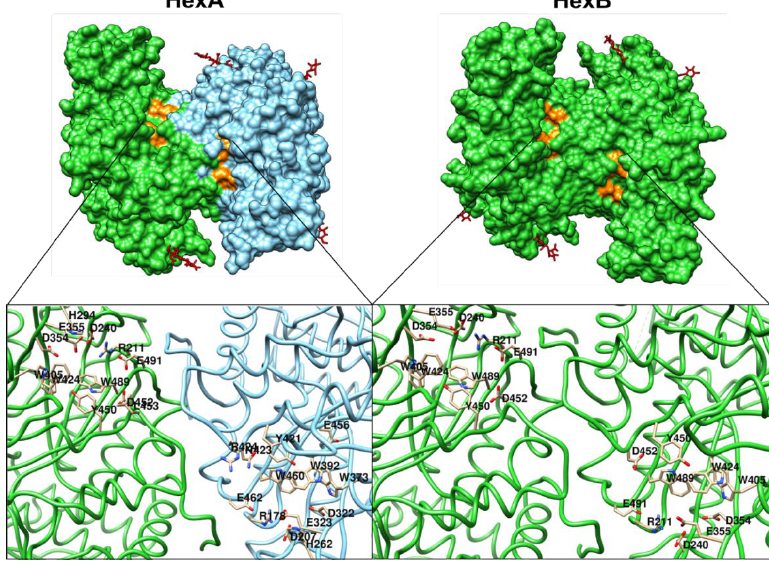
Figure 2. Structure of HexA and HexB. HexA (PDB 2gjx) isolated from human placenta, while HexB (PDB 1o7a) was recombinantly expressed in insect cells. α- and β-subunits are colored in light blue and green, respectively. N-glycans and active sites are colored in red and orange, respectively. The residues present in the active site of each subunit are also shown.